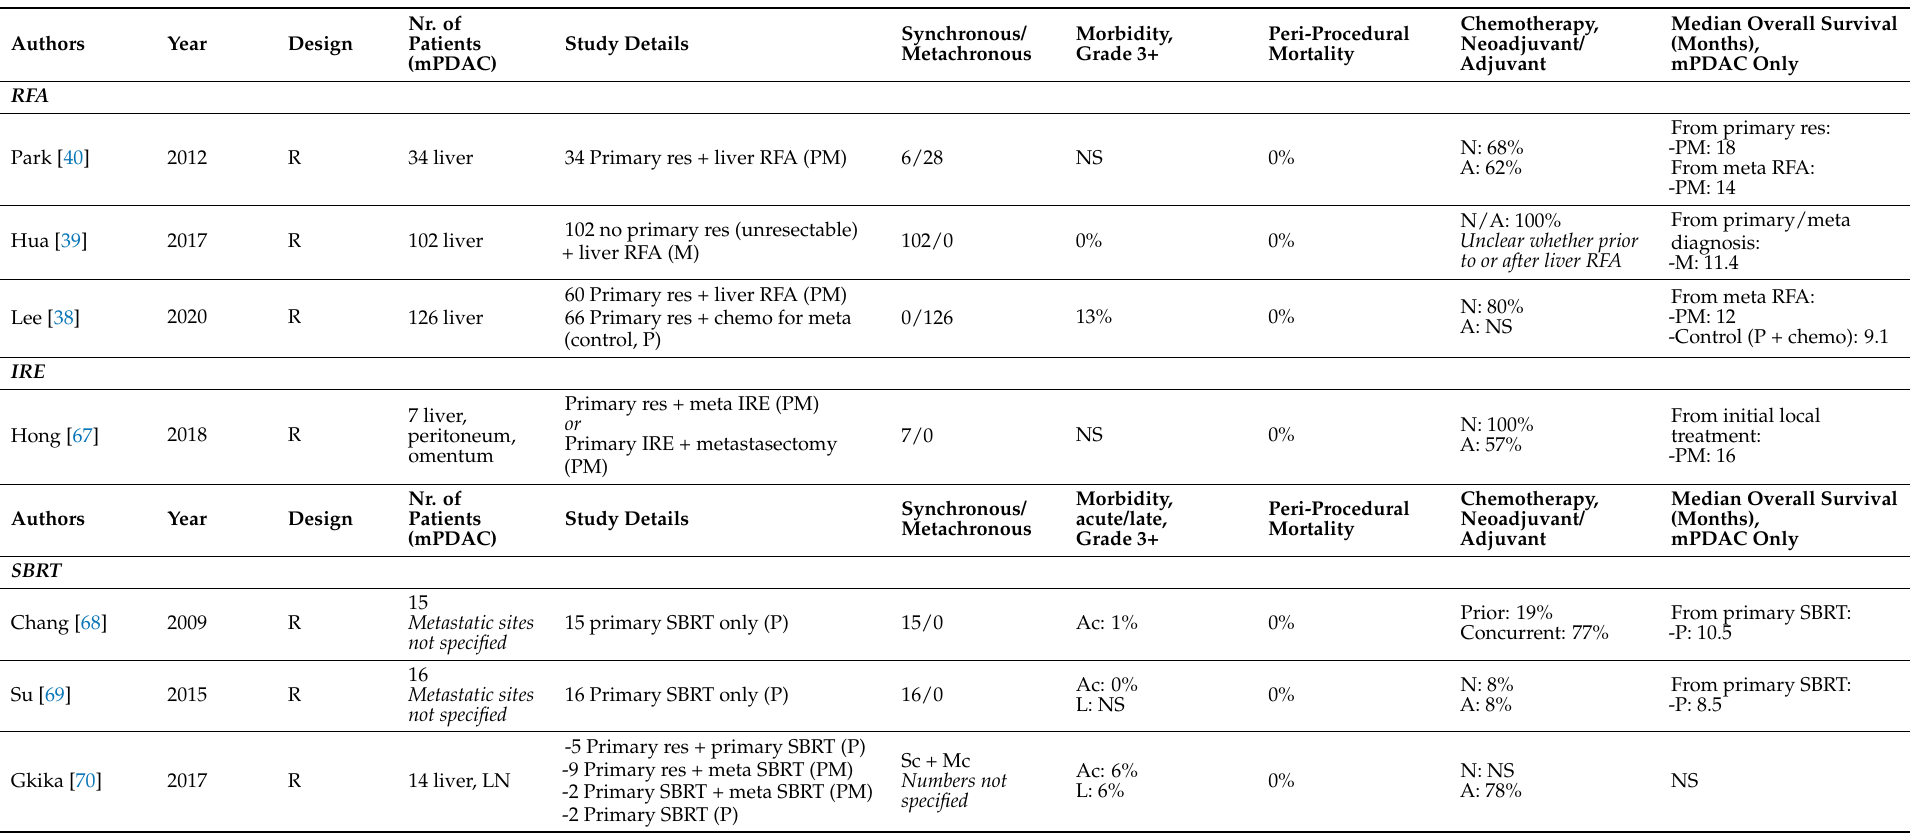
Table 5. Ablation in mPDAC. NS = not specified; R = retrospective; PM = primary + metastatic locoregional treatment; P = primary locoregional treatment; M = metastatic locoregional treatment; res = resection; chemo = chemotherapy; N = neoadjuvant; A = adjuvant; Ac = acute toxicity; L = late toxicity; Sc = synchronous; Mc = metachronous; meta = metastasis; RFA = radiofrequency ablation; IRE = irreversible electroporation; SBRT = stereotactic body radiotherapy; HIFU = high intensity focused ultrasound; LN = lymph nodes; LR = local recurrence; LAPC = locally advanced pancreatic cancer; tox = toxicity; CRT =